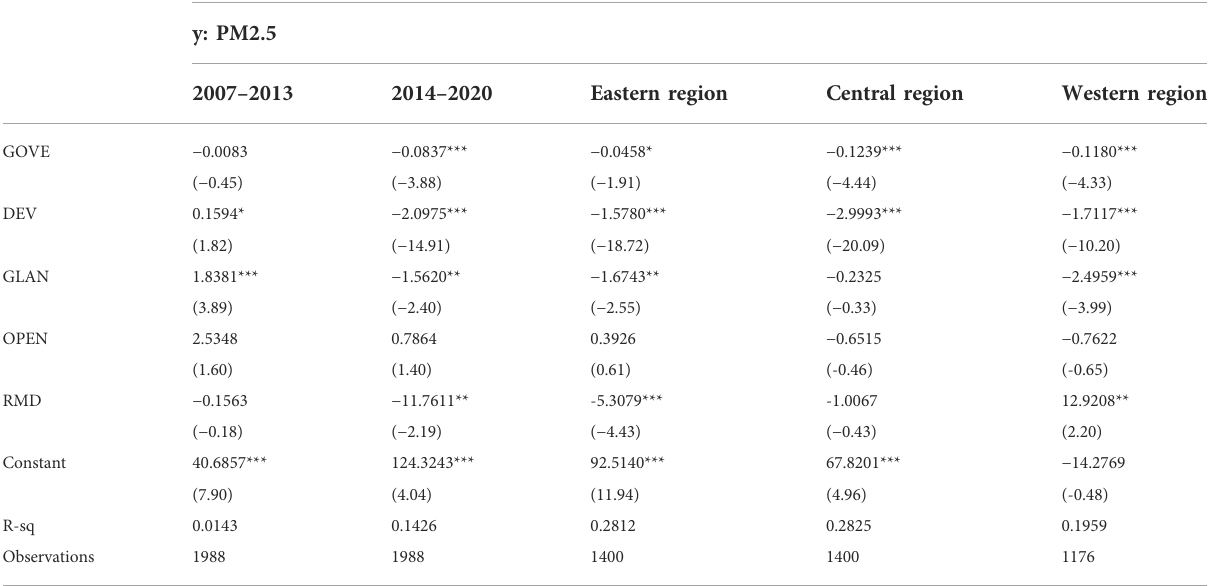
TABLE 6 Temporal and regional